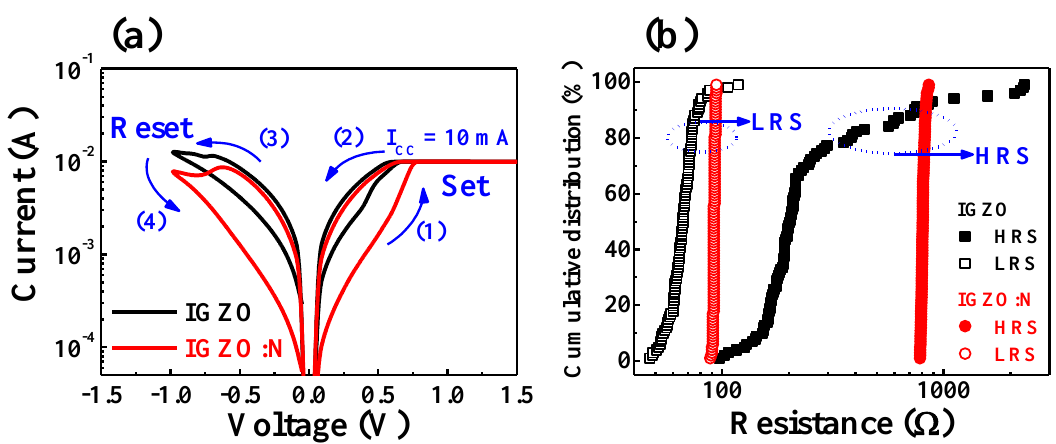
Figure 4. ( a ) Bipolar resistive switching (BRS) I–V characteristic curves and ( b ) cumulative resistance distribution under 10 2 sequential DC cycles of the IGZO and IGZO:N memristor devices.